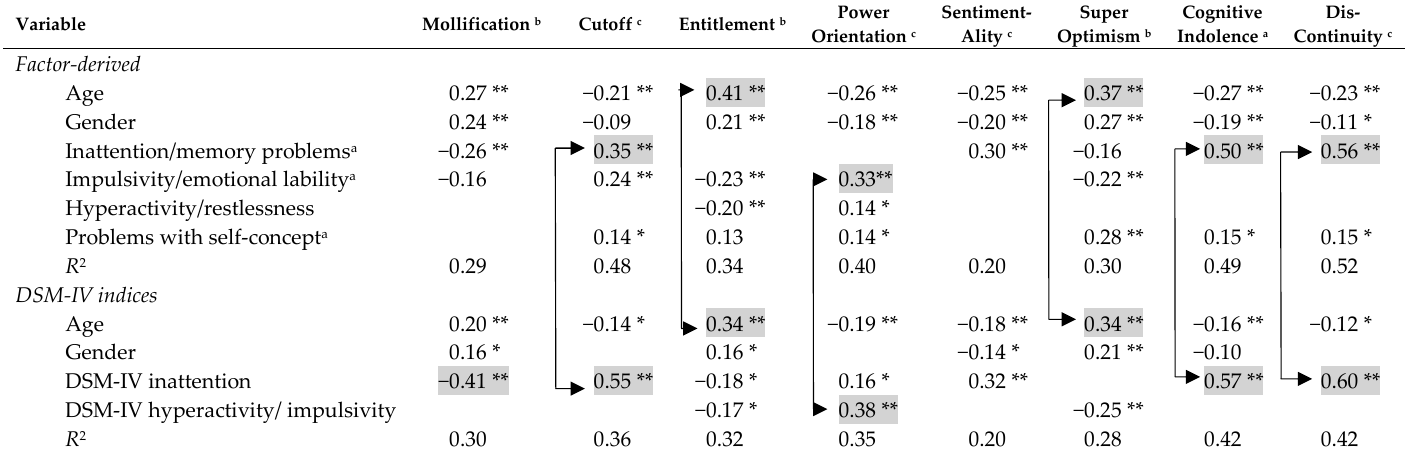
Table 5. Regression model R 2 s and β s of retained predictors on PICTS subscales ( N = 192).